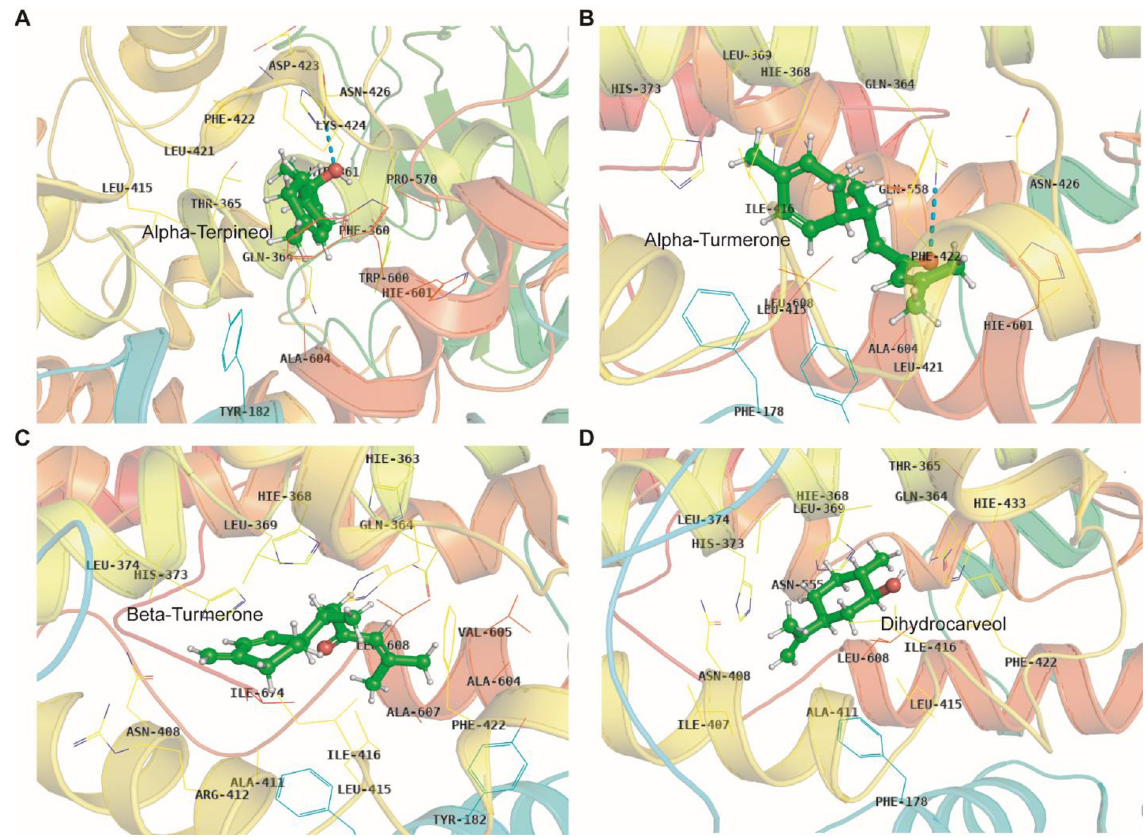
Fig 7. Interaction of ligands with 5-LOX protein obtained from the MD trajectories upon clustering. The protein is shown in cartoon format and the ligands are shown in ball-stick format. The interacting amino acids are labelled in black.